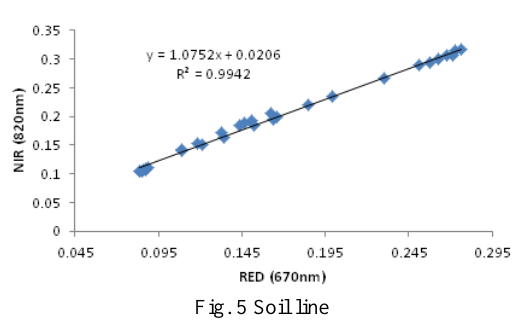
Fig. 4 Spectral reflectance curve (removal of water vapor absorption bands)